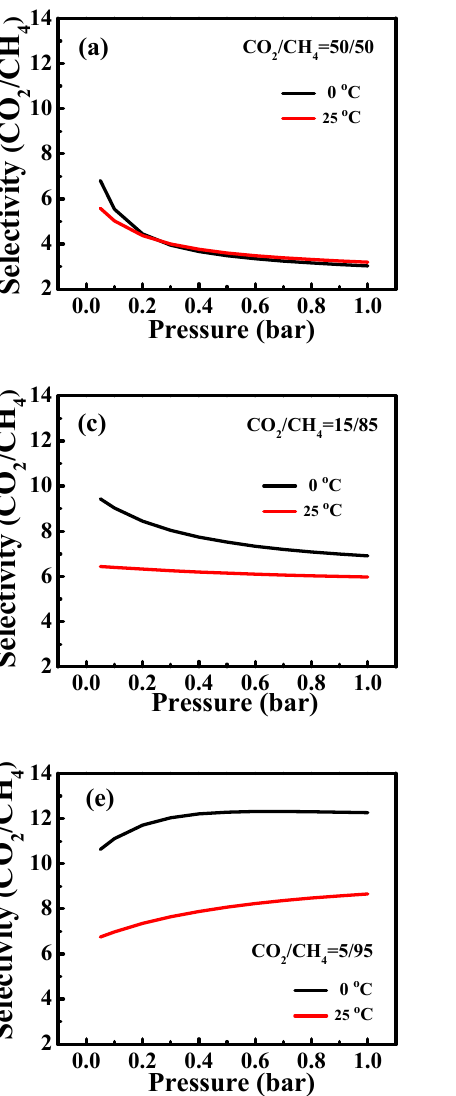
Figure 7. IAST-predicted selectivities assuming different binary mixing ratios on N-WAPC Figure 7. IAST ‐ predicted selectivities assuming different binary mixing ratios on N ‐ WAPC ( a ) ( a ) CO 2 /CH 4 = 50/50, ( b ) CH 4 /N 2 = 50/50, ( c ) CO 2 /CH 4 = 15/85, ( d ) CH 4 /N 2 = 15/85, ( e ) CO 2 /CH 4 CO 2 /CH 4 =50/50, ( b ) CH 4 /N 2 =50/50, ( c ) CO 2 /CH 4 =15/85, ( d ) CH 4 /N 2 =15/85, ( e ) CO 2 /CH 4 =5/95, and ( f ) = 5/95, and ( f ) CH 4 /N 2 = 5/95 at 0 and 25 ◦ CH 4 /N 2 =5/95 at 0 and 25 °C.